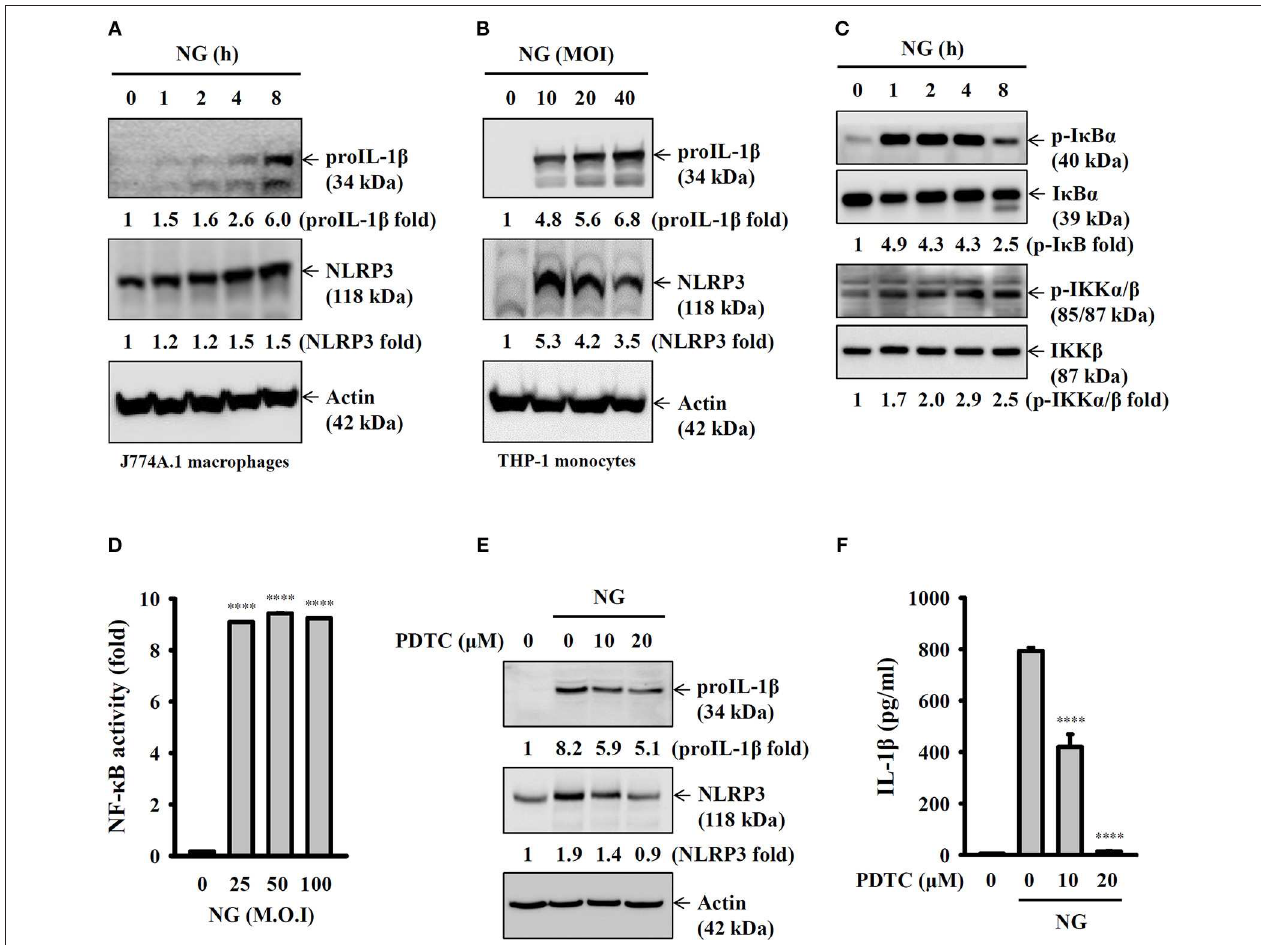
FIGURE 4 | Activation of the NLRP3 inflammasome by NG through NF- κ B-dependent pathways. (A–C) J774A.1 macrophages were infected for 0–8h with NG at 50 MOI (A,C) or THP-1 monocytes were infected for 8h with NG (B) . The levels of proIL-1 β , NLRP3, p-I κ B α /I κ B α , and p-IKK α / β /IKK β in the cell lysates were measured by Western blotting analysis. (D) J-Blue cells were infected for 24h with NG. The activation of NF- κ B was measured by QUANTI-Blue medium. (E) J774A.1 macrophages were incubated for 0.5h with PDTC, followed by infection for 8h with NG at 50 MOI. The levels of proIL-1 β and NLRP3 in the cell lysates were measured by Western blotting analysis. (F) J774A.1 macrophages were incubated for 0.5h with PDTC, followed by infection for 24h with NG at 50 MOI. The levels of IL-1 β in the supernatants were measured by ELISA. The ELISA data are expressed as the mean ± SD of three separate experiments. The Western blotting results are representative of three different experiments, and the band intensity was analyzed by ImageJ and expressed as the fold change compared with the control group normalized to actin or corresponding total protein. A significant difference at the level of **** p < 0.0001 compared to untreated control cells (D) or NG-infected cells (F) . (One-way ANOVA with Dunnett’s multiple comparisons